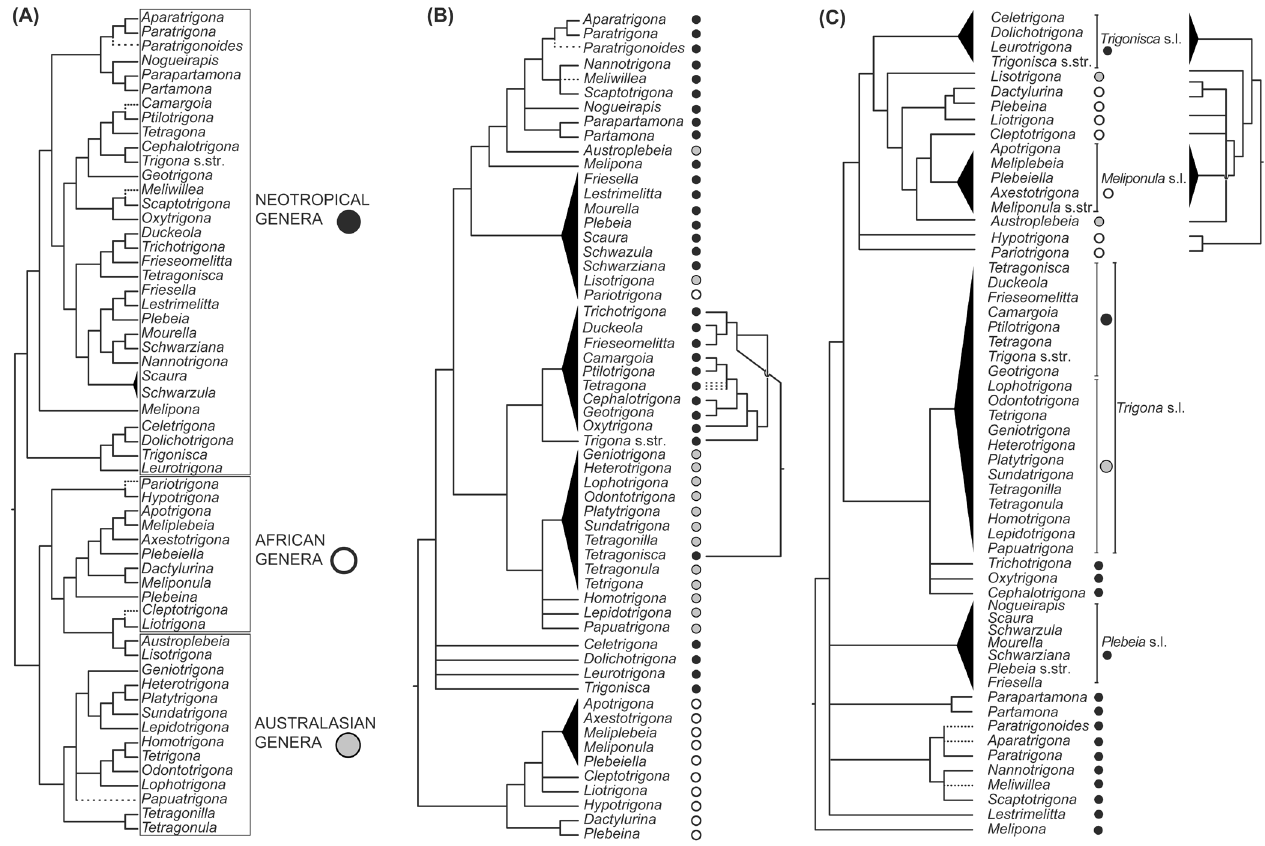
Fig 4. Summary of the phylogenetic relationships among the genera of stingless bees (Apidae: Meliponini) as proposed by (A) Rasmussen and Cameron (2010) – molecular dataset; (B) Camargo and Pedro (1992a), accompanied by a more detailed account of relationships among Neotropical genera later studied by Camargo and Pedro (2003) on the left – both morphological datasets; and (C) Michener (1990) – morphological dataset – showing two alternative scenarios for the inner relationships of one of the clades. The genus-level classification was standardized to match Rasmussen and Cameron’s classification and thus make the three hypotheses readily comparable. When one of the three analyses did not include a given genus, a putative position was defined for it and dashed lines represented the placement of this genus. For example, the following five genera were not originally included in the analysis by Rasmussen and Cameron (2010): Camargoia , Cleptotrigona , Meliwillea , Papuatrigona , and Paratrigonoides ; putative placement of these in this summary tree was based on hypotheses and comments by various authors (Michener, 1990; Roubik et al., 1997; Camargo & Pedro, 2004; Camargo & Roubik, 2005), as previously indicated by Rasmussen and Cameron